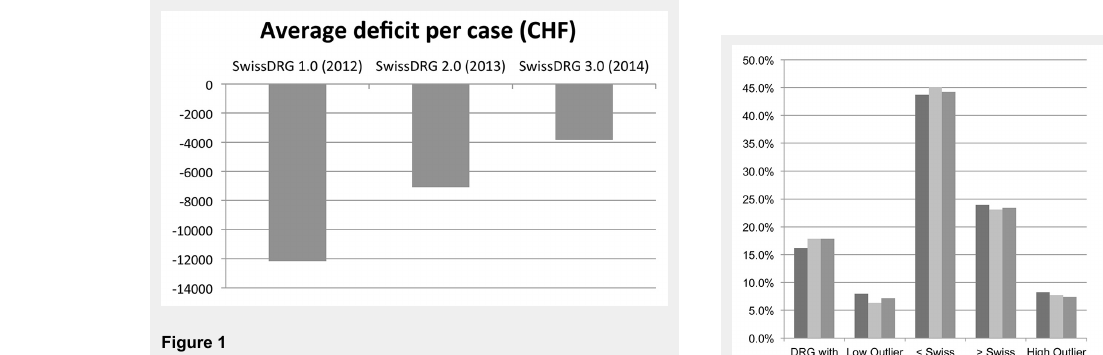
Average deficit under different SwissDRG catalogue versions. Average deficits were calculated as the mean of diagnosis-related group (DRG) revenue minus total costs per case. DRG revenue was determined by multiplying the effective case-mix points of the case’s DRGs as defined by the different catalogue versions (V1.0, 2014; V2.0, 2013; V3.0, 2014) by a base rate of 11300 CHF. Supplementary payments (“Zusatzentgelte”) were taken into account.